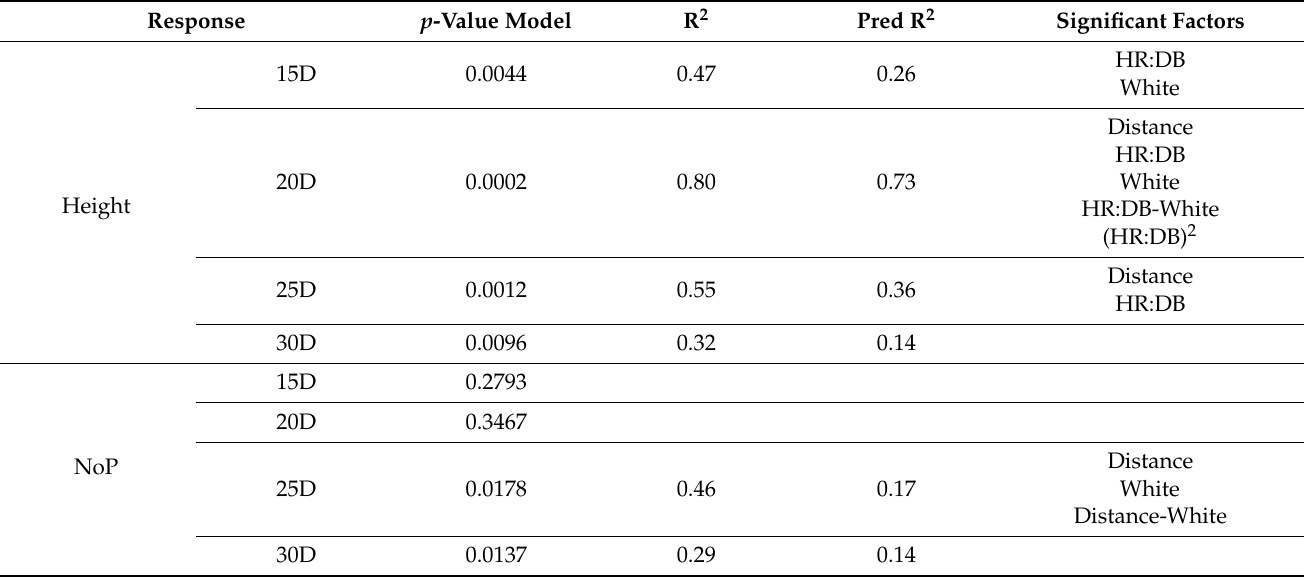
Table 7. Results of ANOVA